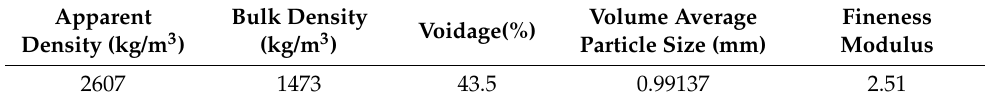
Table 4. Main technical properties of